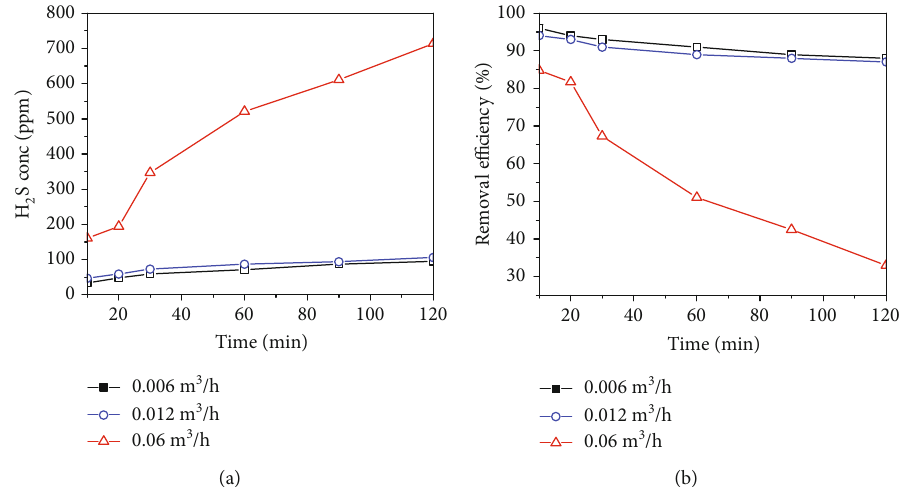
Figure 8: E ff ect of biogas fl owrate on RR adsorption performance: H m = 0 : 6g , T = 1000 ° C , particlesize = 0 : 32 ‐ 250 μ m , and C c